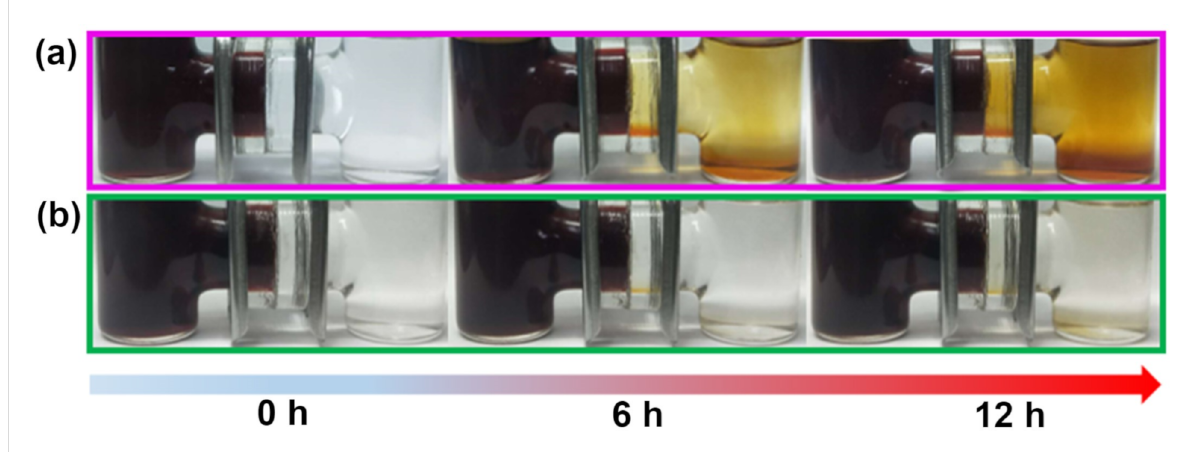
Figure 9: Optical images of the diffusion process of the polysulfides through the (a) pristine separator and the (b) TiO 2 /GO-coated separator.